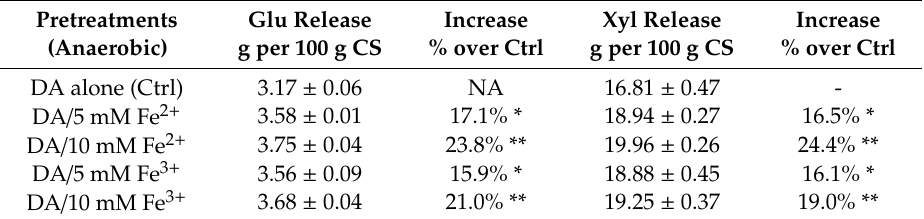
Table 1. Release of glucose and xylose from corn stover by DA/Fe pretreatments (at 150 °C, 20 min) under anaerobic conditions. The released sugars were quantitated by high-performance liquid chromatography (HPLC) analysis of the liquor after the pretreatment. Values are presented as means ± standard error of the mean (± SEM) of four replicates for each of the pretreatments. Asterisk indicates statistically significant difference from the control (* for p < 0.05; ** for p < 0.01). Abbreviations: Ctrl, control; DA, dilute acid; Glu, glucose; NA, not applicable; Xyl, xylose.